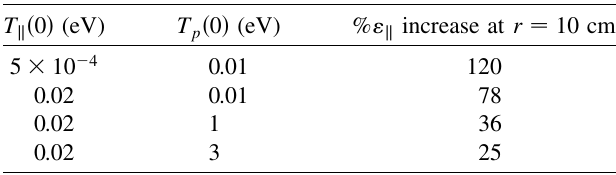
TABLE II. Change in longitudinal emittance with initial beam and plasma